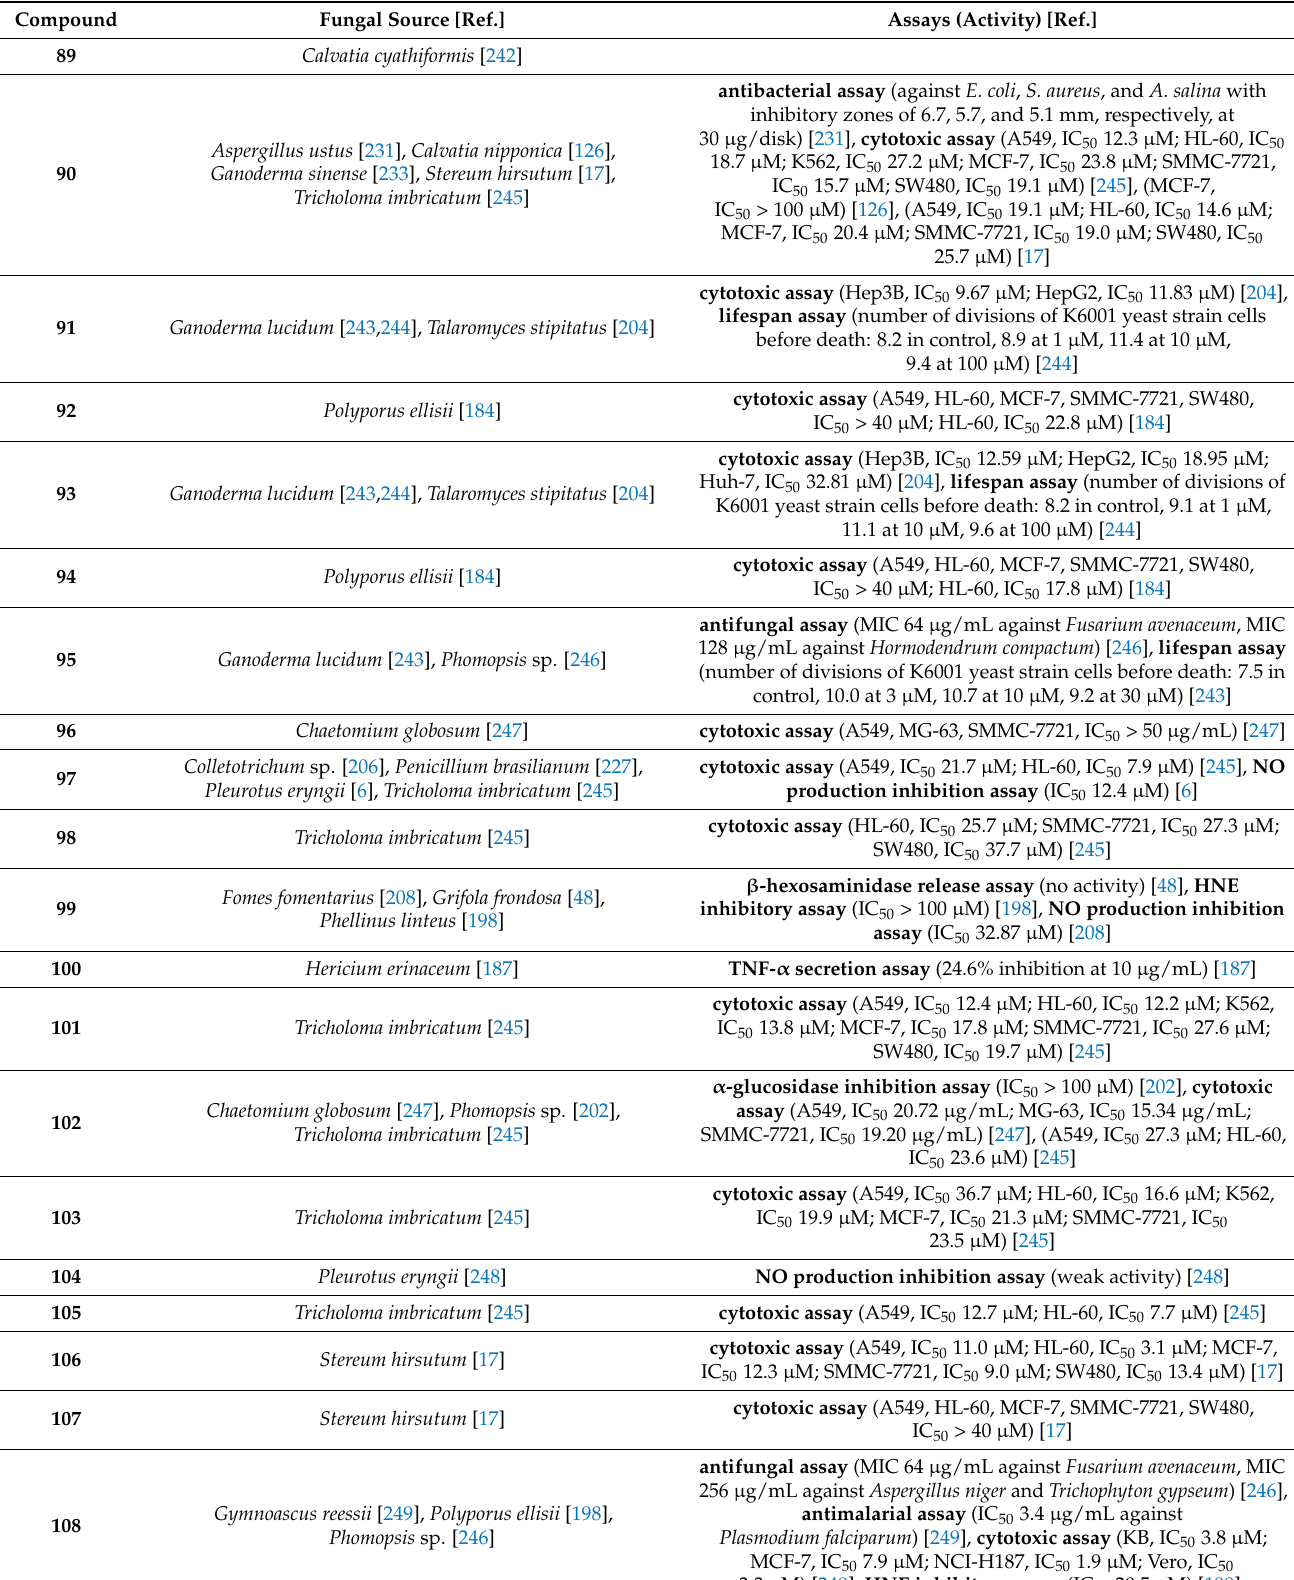
Table 4. Sources and biological activity of fungal hydroxyketones. Fungal Source